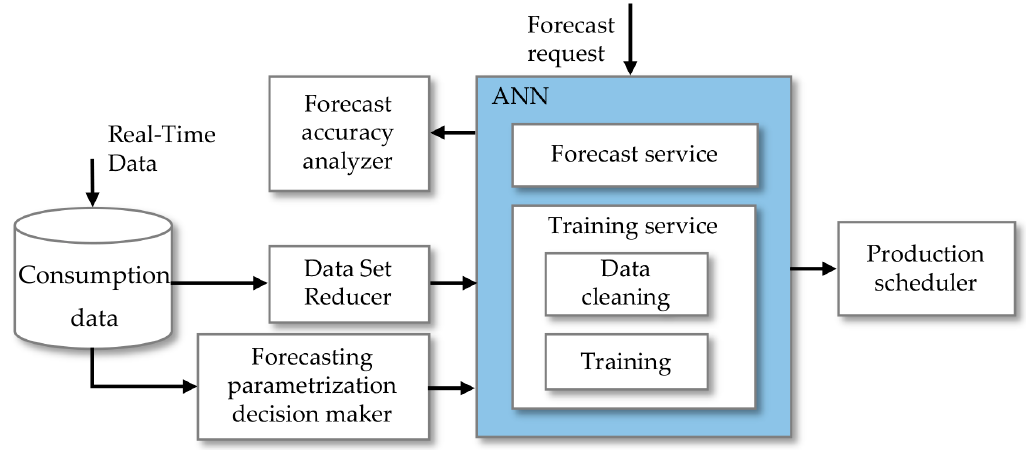
Figure 1. Proposed methodology diagram regarding the forecast and production planning update. ANN: Artificial Neural